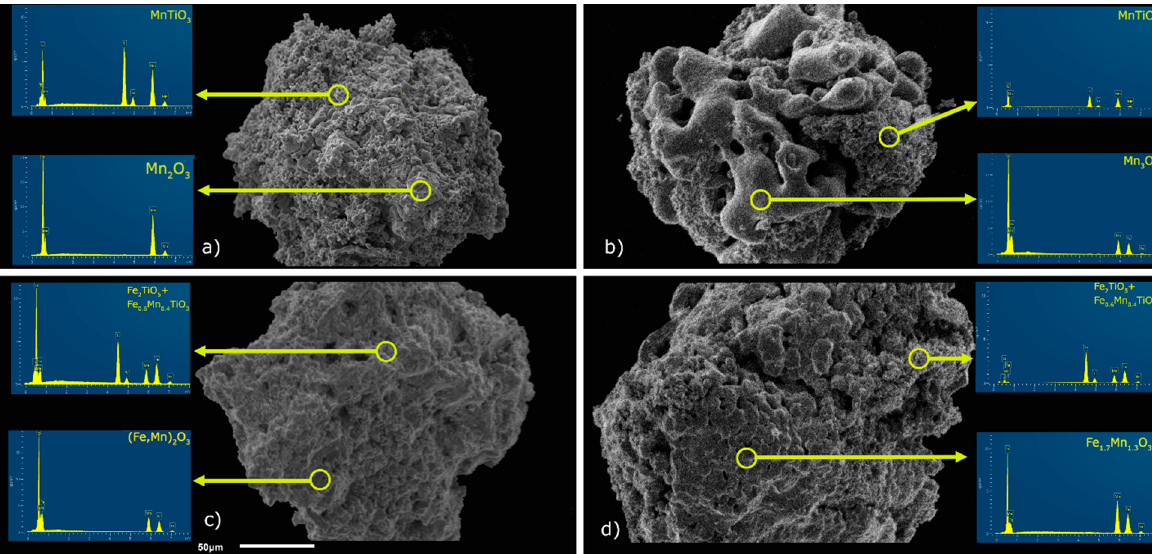
Figure 7. EDS analysis for selected OC grains: fresh M85 ( a ), reacted M85 ( b ), fresh F50M35 ( c ) and reacted F50M35 ( d ).